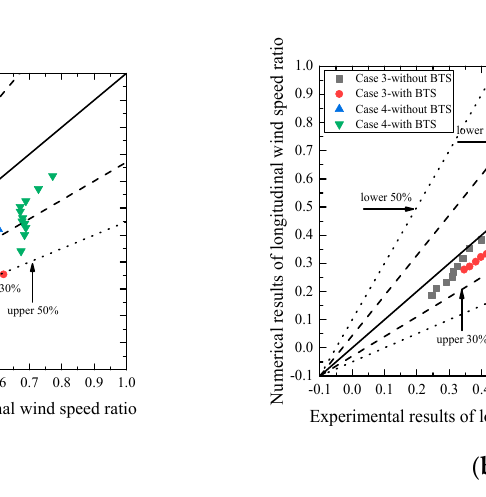
Figure 20. Numerical results vs. experimental results of longitudinal wind speed ratio at L/4 under different cases. ( a ) Case 1 and 2; ( b ) Case 3 and 4.